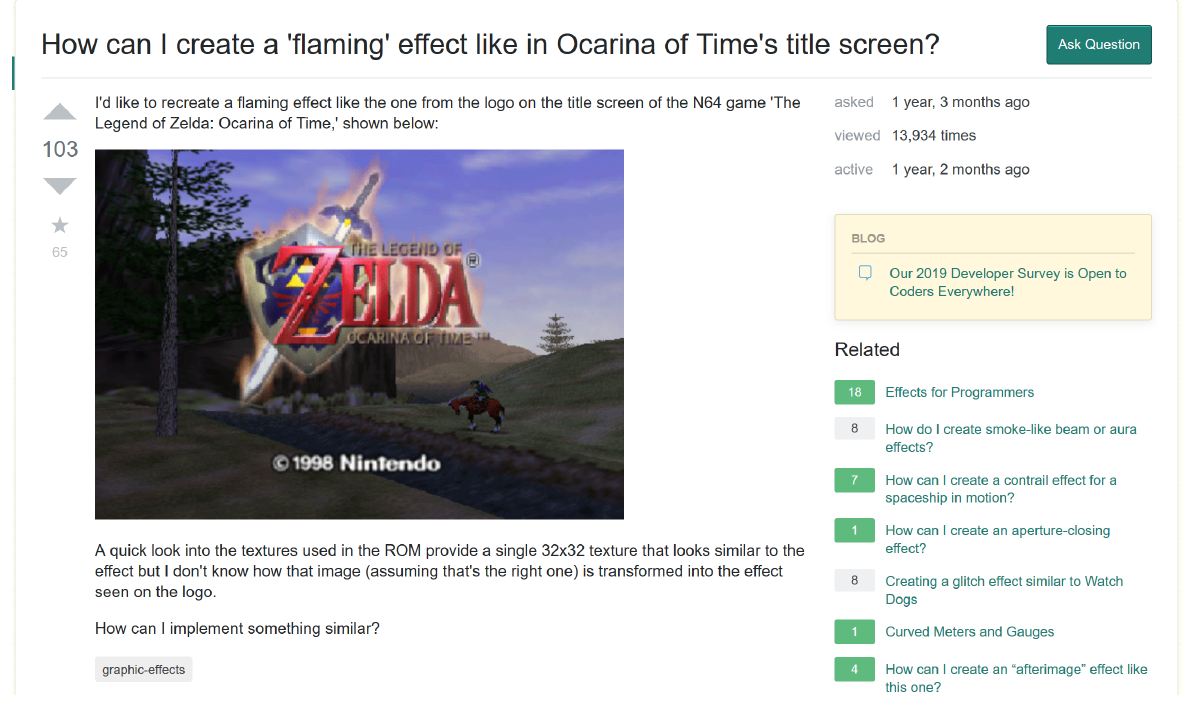
Figure 1. Example of a question on Game Development Stack